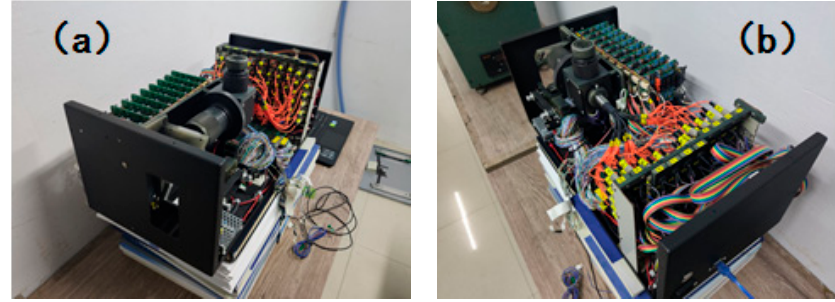
Figure 3. A physical figure of the two-dimensional array pyrometer: ( a ) front and ( b ) back.